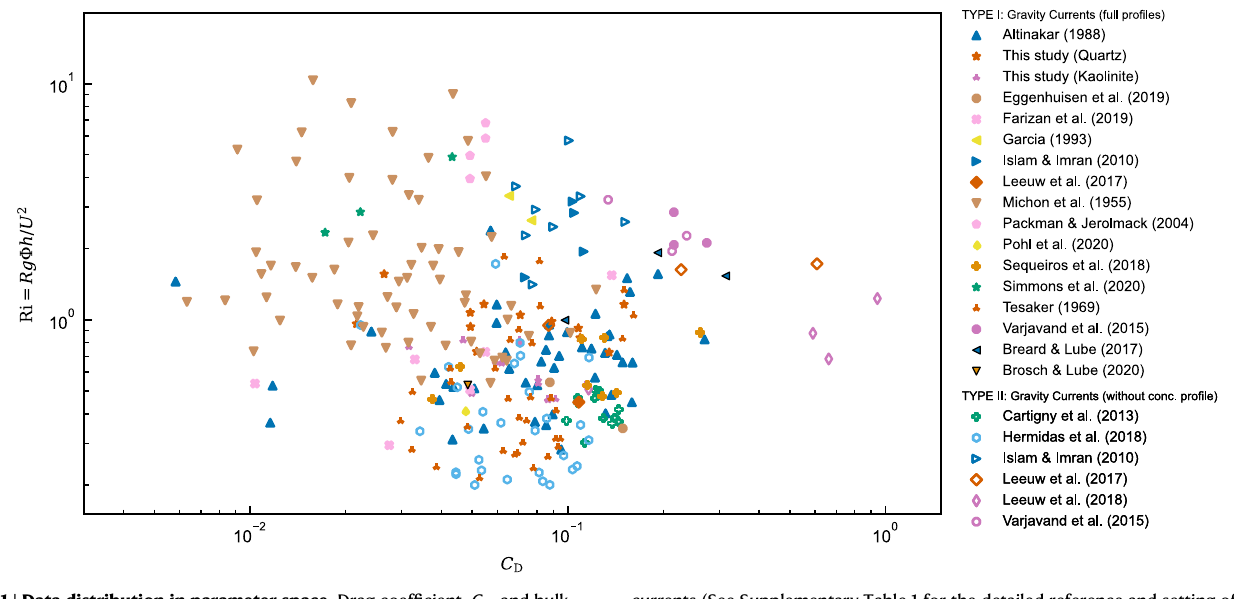
currents (See Supplementary Table 1 for the detailed reference and setting of experiments in each source). Black borders denoted pyroclastic density current experimental data.